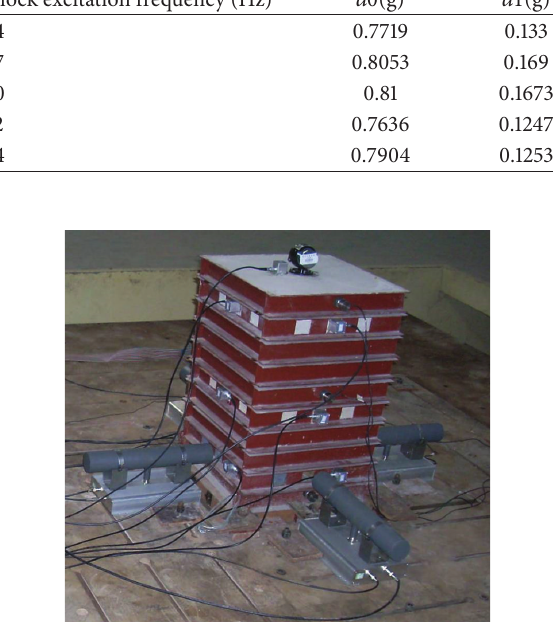
Figure 11: Arrangement of each